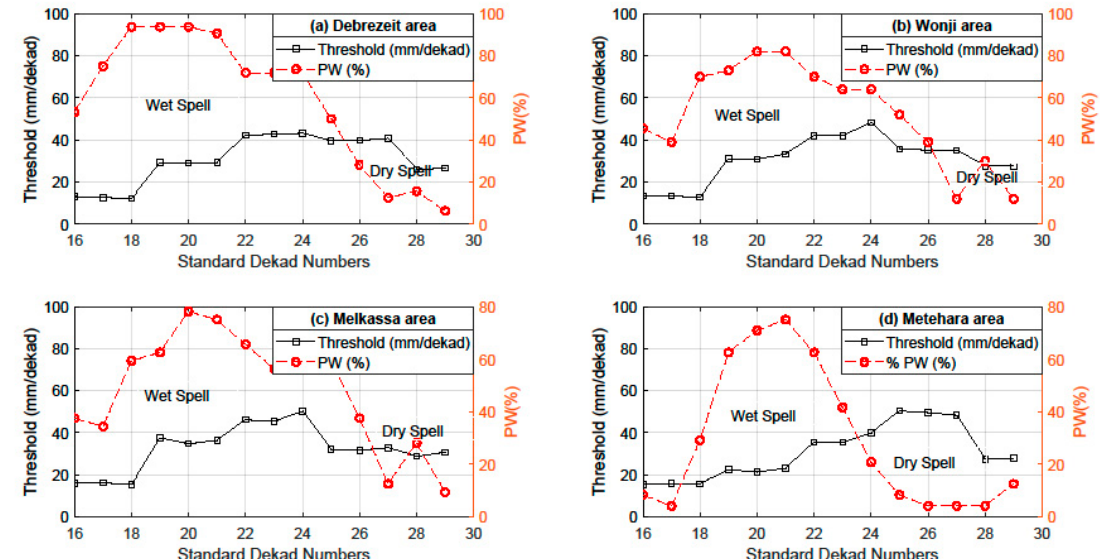
Figure 4. Initial probability of a dekad being wet ( P W ) (%) value exceeding the threshold value (mm/dekad) in the Kiremt seasons.